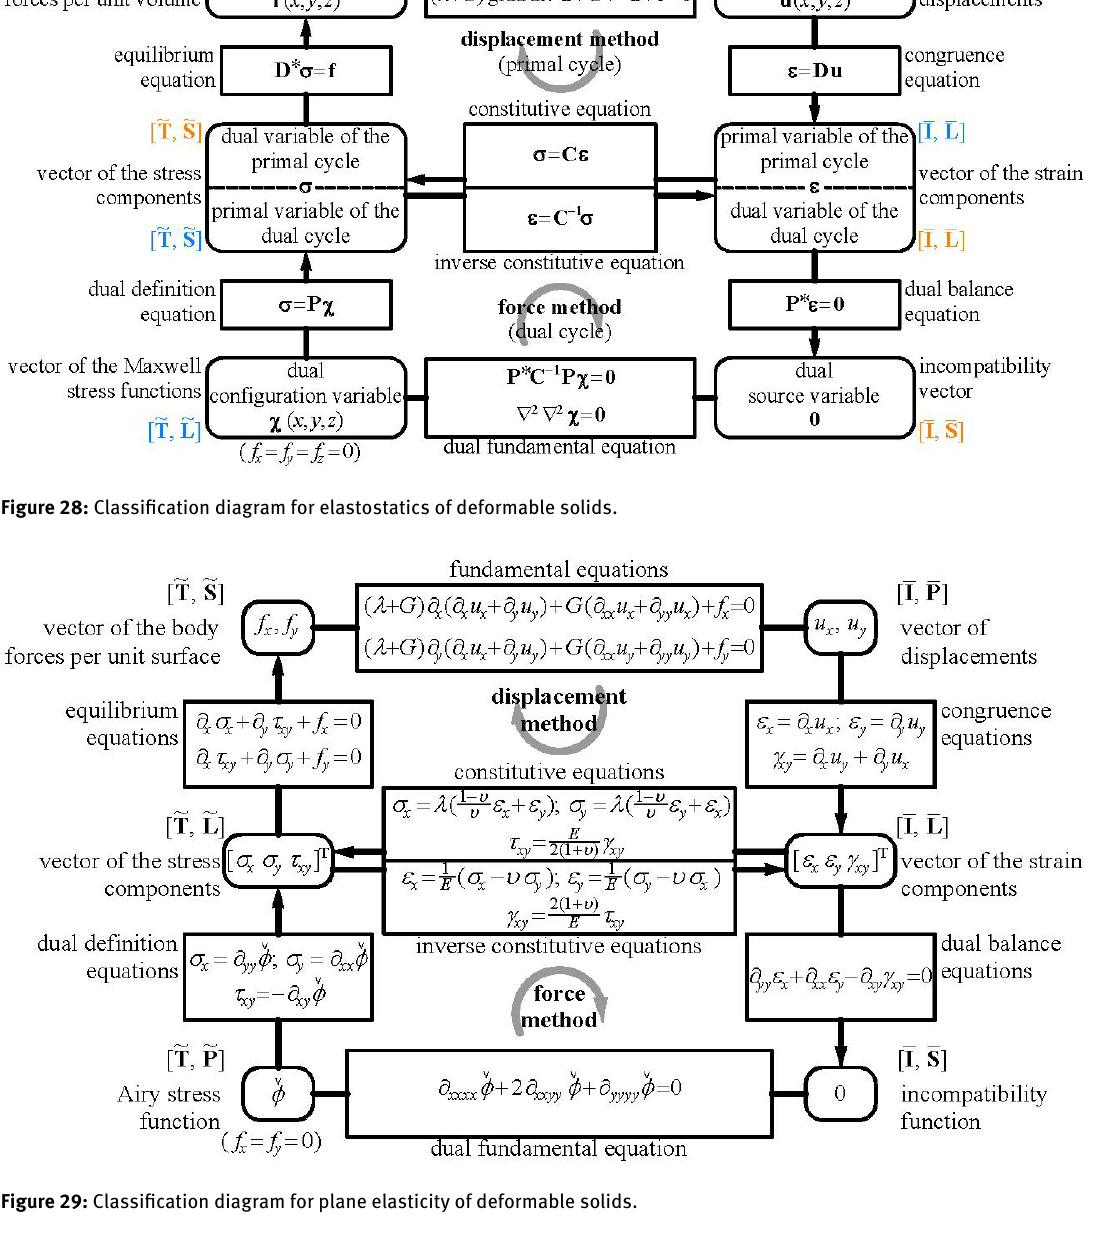
Figure 29: Classification diagram for plane elasticity of deformable